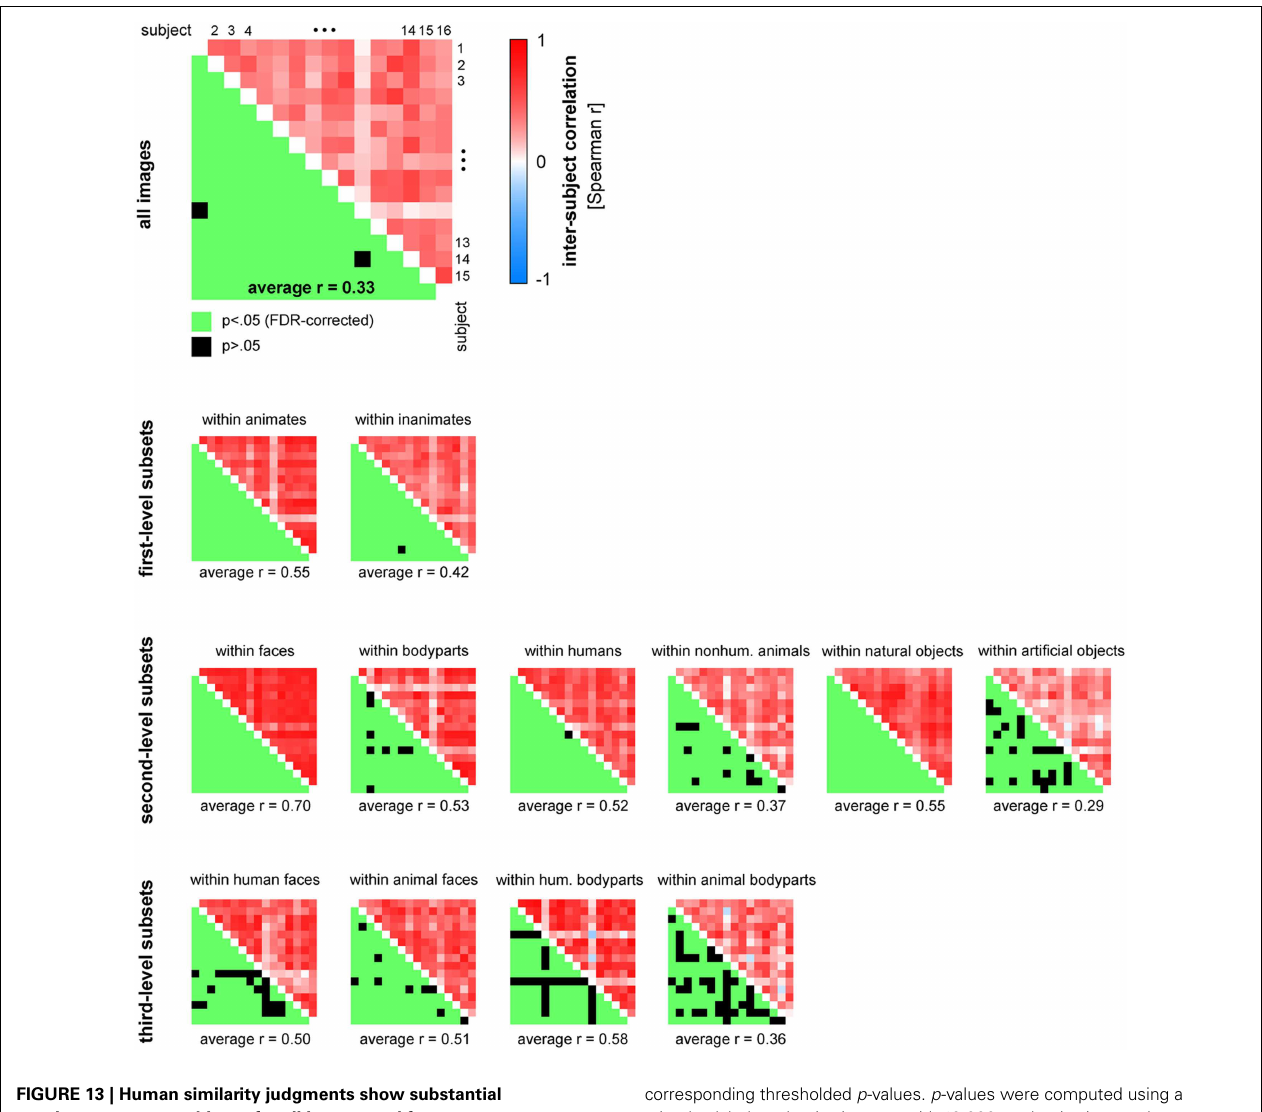
FIGURE 13 | Human similarity judgments show substantial consistency across subjects, for all images and for most category subsets of images. The upper triangle of each matrix shows all possible pairwise inter-subject RDM correlations (Spearman r ).The mirror-symmetric entries in the lower triangle of each matrix show the